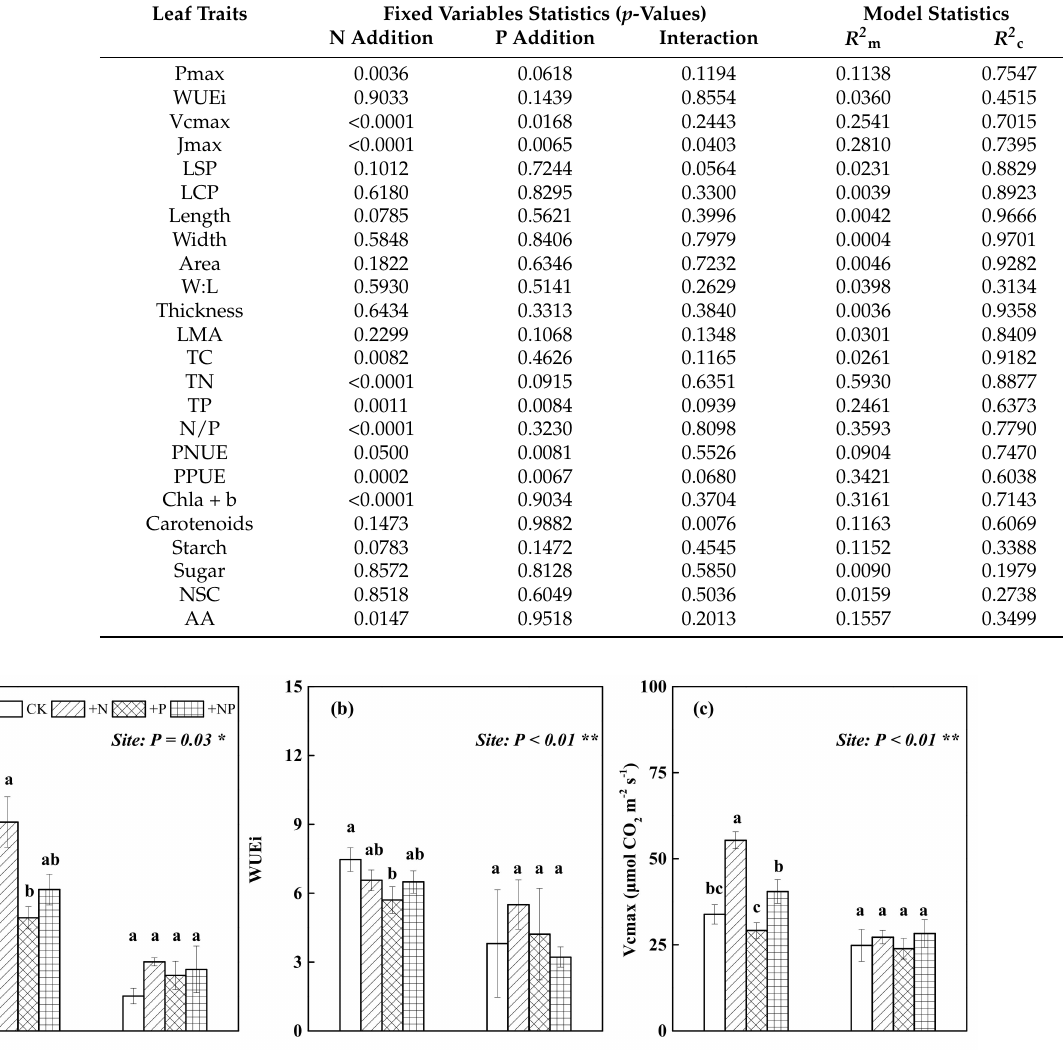
Table 1. Significance ( p -values) and model statistics from linear mixed-model analysis for light- saturated photosynthetic rate (Pmax); water use efficiency (WUEi); the maximum rate of carboxylation (Vcmax); the maximum rate of electron transport (Jmax); light saturation point (LSP); the light compensation point (LCP); leaf length, width, area, width:length (W:L), thickness; leaf mass per area (LMA), thickness; leaf C, N, P concentrations (TC, TN and TP); N/P, photosynthetic N use